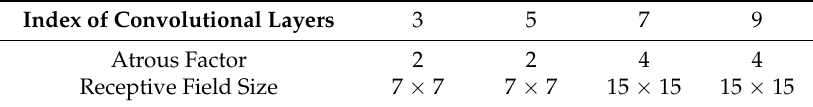
Table 1. Parameters of atrous convolution in the AE